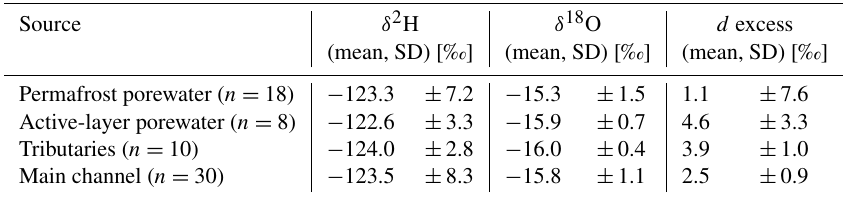
Table 2. Stable water isotope values mean and standard deviation by source. Source δ 2 H δ 18 O d excess (mean, SD) [‰] (mean, SD) [‰] (mean, SD) [‰] Permafrost porewater ( n = 18) − 123.3 ± 7.2 − 15.3 Active-layer porewater ( n = 8) − 122.6 Tributaries ( n = 10) −